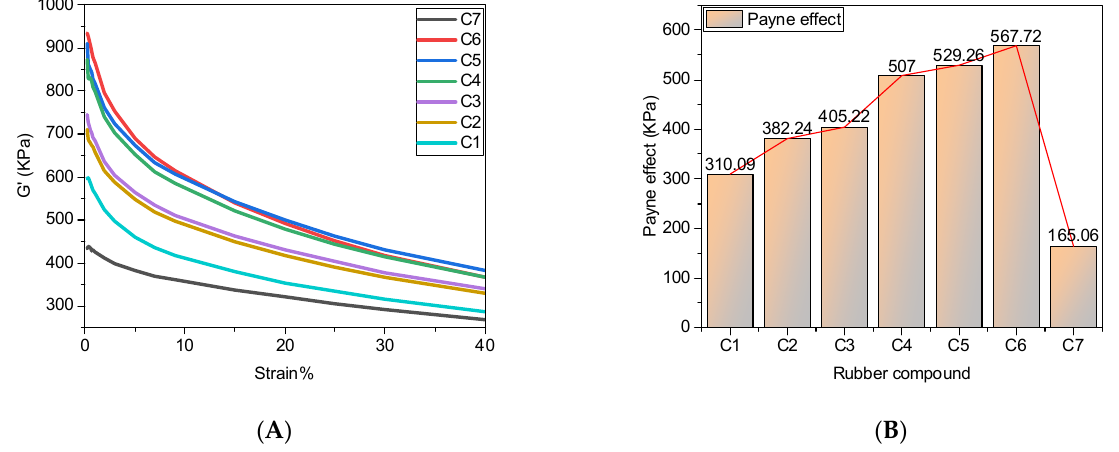
Figure 5. Rubber processing properties. ( A ) Stress ‐ strain curve; ( B ) Payne effect